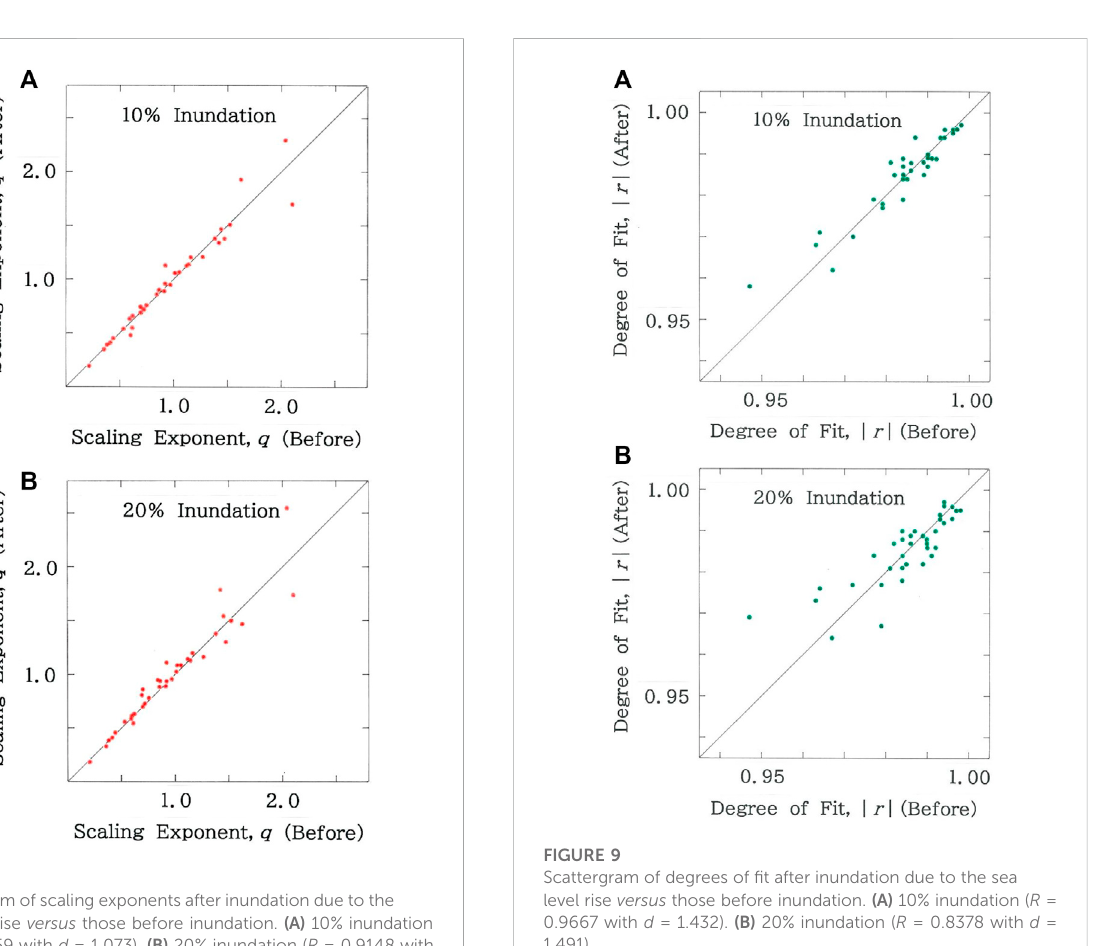
i . Figure 8 plots the scattergram of scaling exponents after